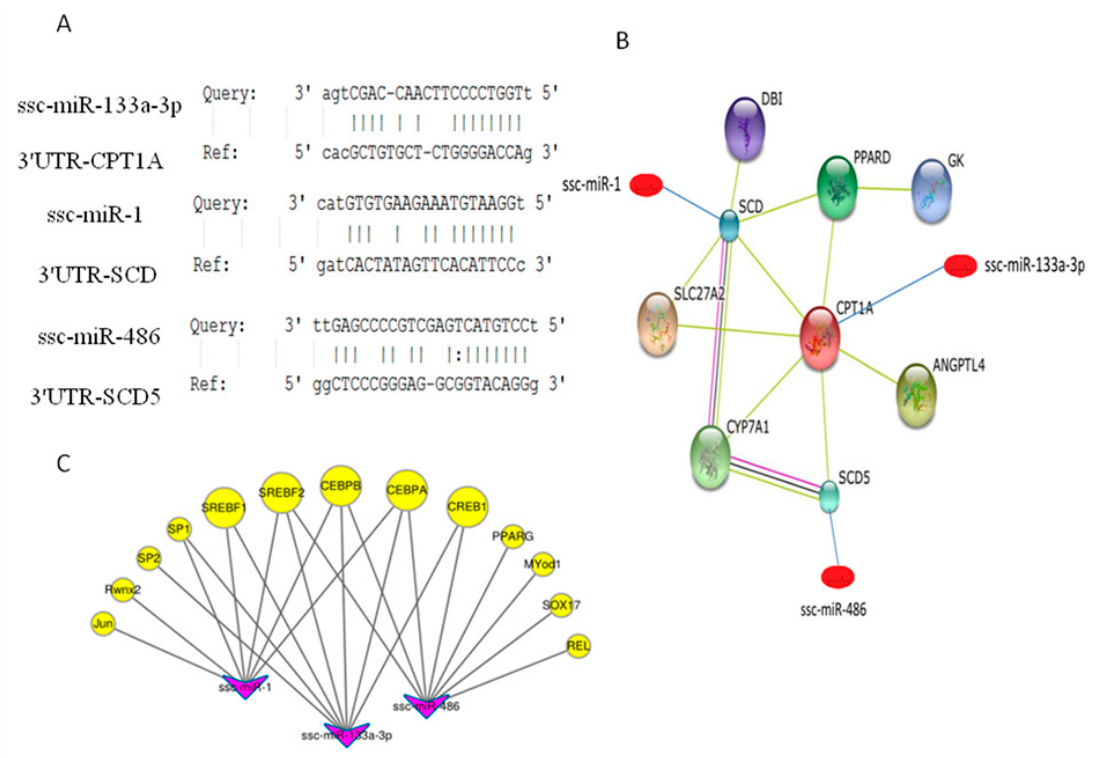
Figure 4. Relationships between ssc-miR-133a-3p, ssc-miR-1, ssc-miR-486 and the targeted genes CPT1A, SCD and SCD5, as well as the transcription factors binding to these miRNAs. ( A ) represents the result of the target gene prediction of ssc-miR-133a-3p, ssc-miR-1 and ssc-miR-486, using miRanda software. ( B ) represents the protein-protein interactions and the interactions of the miRNAs with the CPT1A, SCD and SCD5 genes in the PPAR pathway. ( C ) represents the interactions of ssc-miR-133a-3p, ssc-miR-1 and ssc-miR-486, with the transcription factors binding to them. The yellow nodes indicate the transcription factors, and the pink nodes indicate the miRNAs.